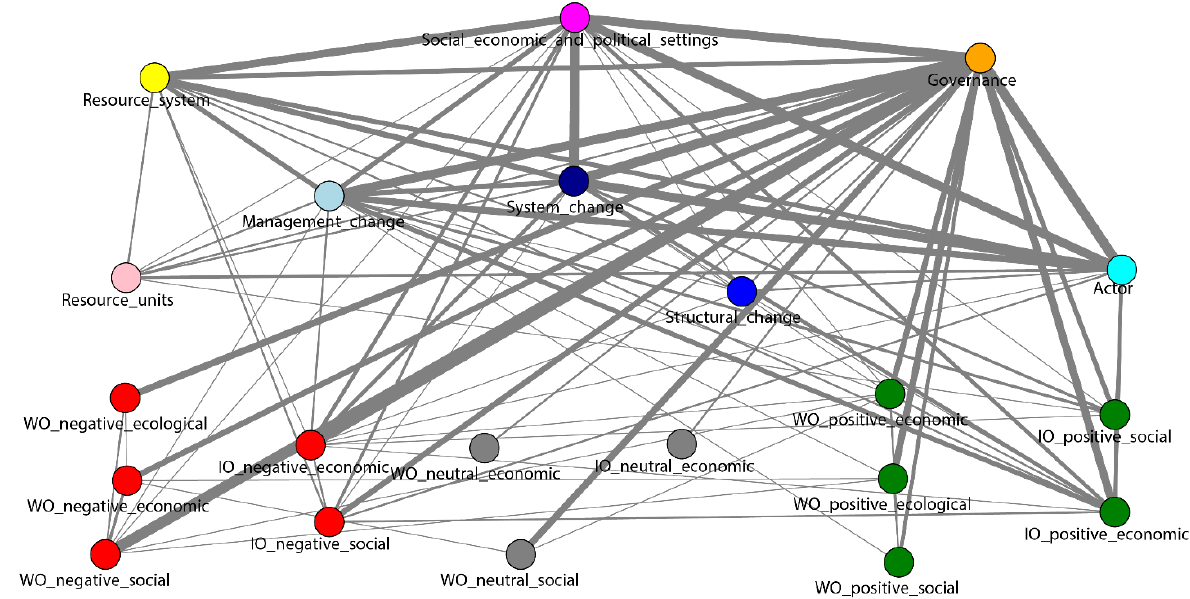
Figure A1.1. Network graph representing group mental model of Taupo farmers’ watershed social- ecological system. The arrangement of nodes mimics the structure of the SES Framework in Error! Reference source not found. above. Color of node represents the category of node: driver nodes are orange (governance), magenta (social, economic and political settings), yellow (resource system), cyan (actor), and pink (resource system); behavior nodes are light blue (management), blue (structural) and navy (system); watershed (WO) and individual (IO) outcomes nodes are red (negative), grey (neutral) and green (positive).